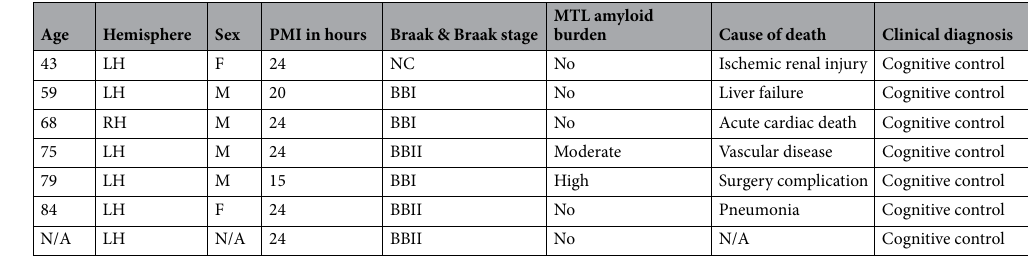
Table 1. Basic demographic information for cases used in study. BBI Braak & Braak stage I, BBII Braak & Braak stage II, cognitive control cognitively healthy, F female, M male, MTL medial temporal lobe, N/A